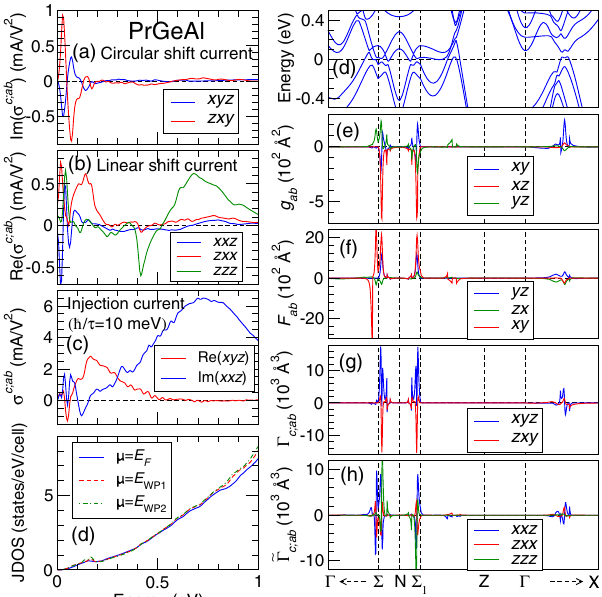
FIG. 6. Conductivity tensors and geometric quantities in ferromagnetic PrGeAl. (a,b) Shift and (c) injection conductivity tensors. (d) JDOS as a function of photon energy. The cases with μ ¼ E and μ ¼ E are also shown. (e) Energy bands, WP 1 WP 2 (f) quantum metric g , (g) Berry curvature F , (h) Christoffel ab ab ˜ Γ symbol Γ , and (i) symplectic Christoffel symbol along c ; ab c ; ab the high-symmetry lines in the Brillouin zone [see Fig. 9(d) in Appendix